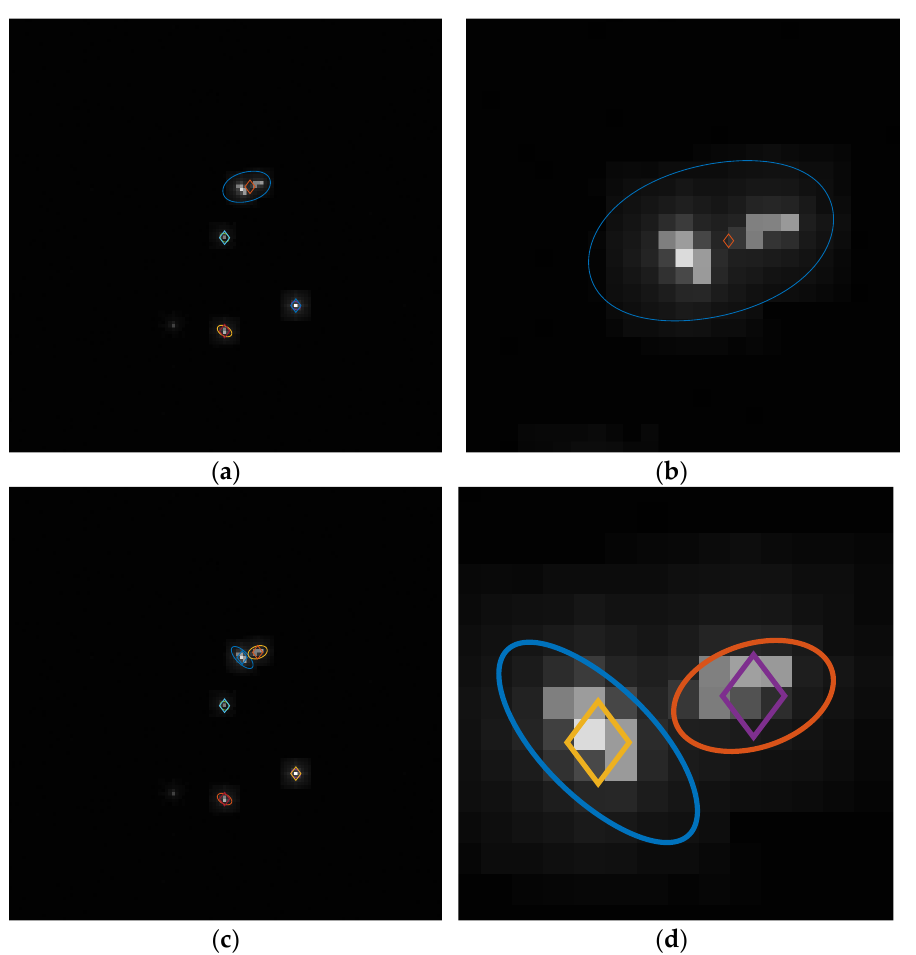
Figure 3. Results of measurement partitioning based on the amplitude of the infrared image. ( a ) the partitioning result of the frame 36th using H-K algorithm; ( b ) the enlarged image of ( a ); ( c ) the further divided result using k-means; ( d ) the enlarged image of ( c ).